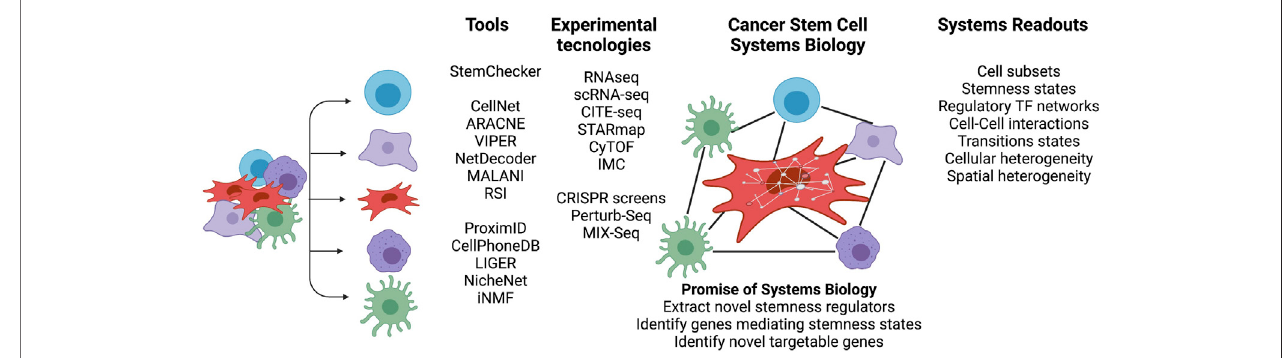
FIGURE 2 | Cancer stem cell systems biology — Novel insights gained by integrated analyses. Overview of breadth of high-throughput technologies and tools to characterize the cross talk between CSCs, immune and tumor cells in a cellular niche. The niche cell subsets can be probed, for example, using bulk and single cell RNA-seq or cytometry by time-of- fl ight (CyTOF). CITE-Seq, STARmap and IMC (imaging cytometry) can spatially probe the cellular niche. A variety of systems tools provide a framework to interrogate signaling pathways, derive regulatory TF networks and understand the diversity of CSC phenotypes and their niches. Figure created with